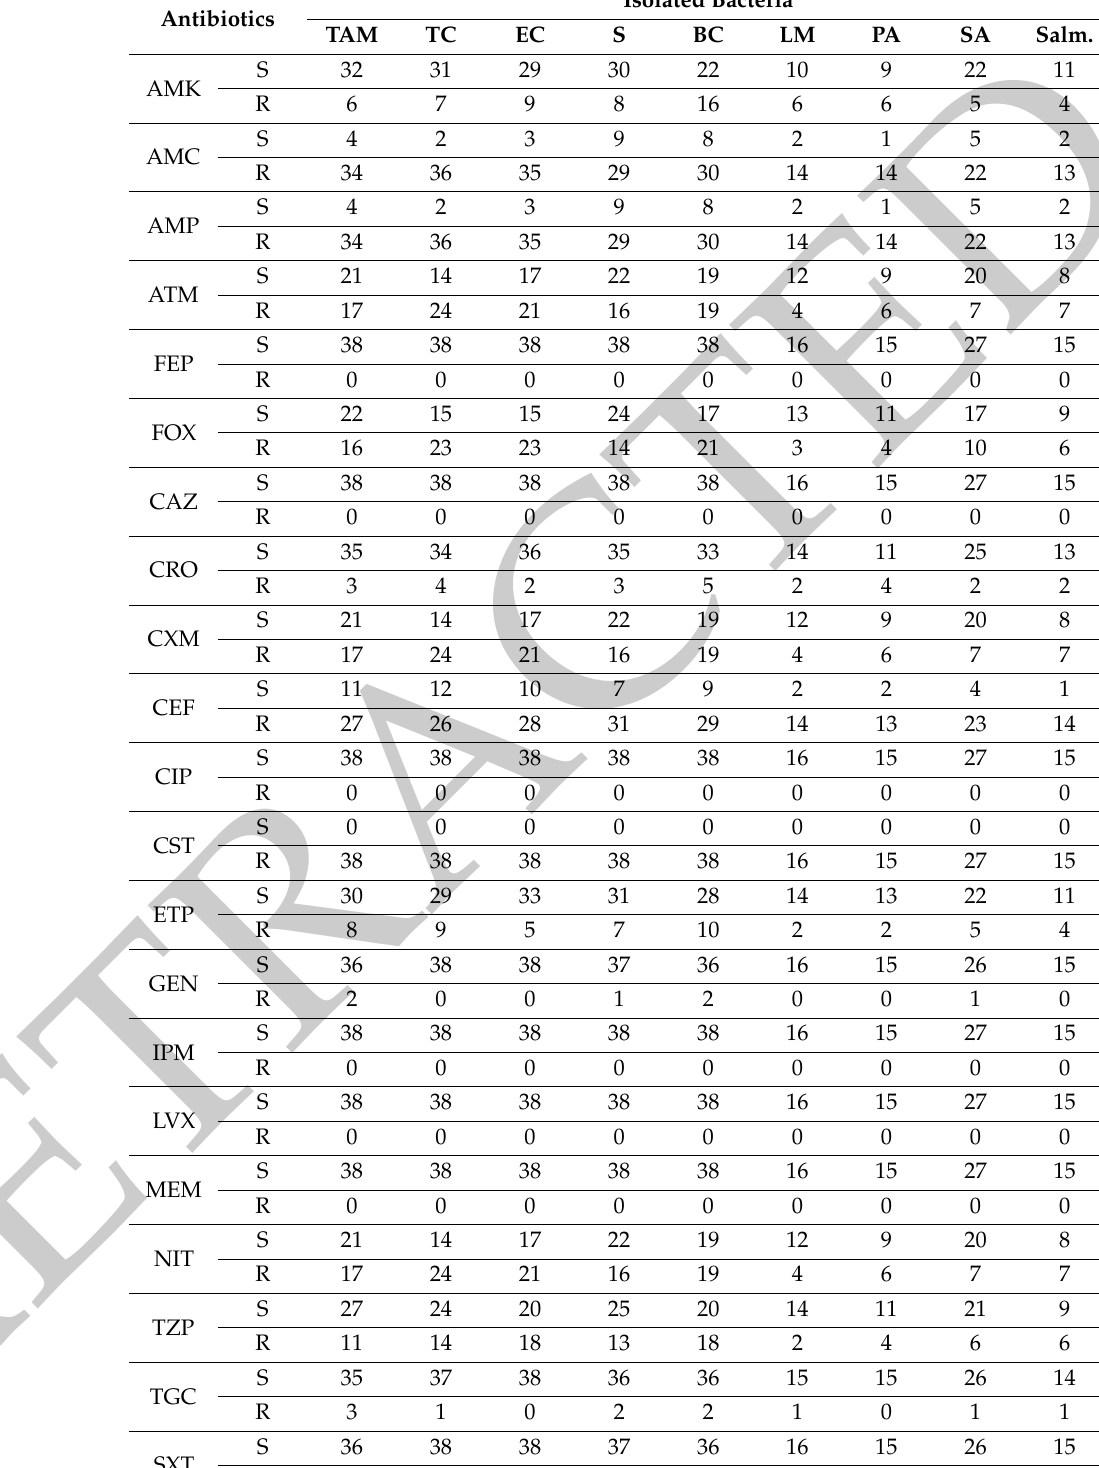
Table 5. Antibiogram of the isolated